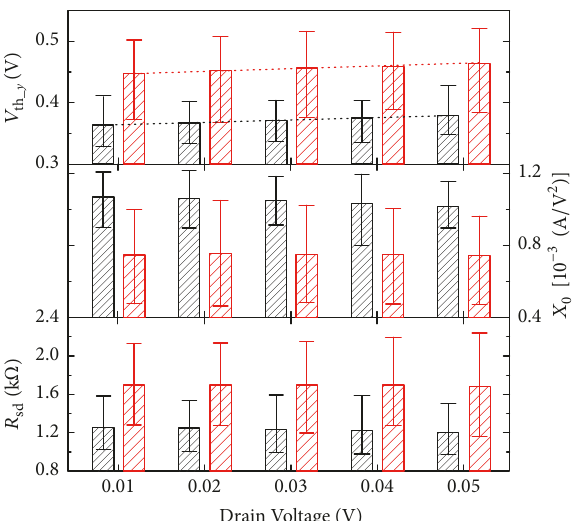
Figure 4: Average and standard deviations of dc parameters for the SOI FinFETs with 𝑇 𝑉 , 𝑋 0 , and 𝑅 . th 𝑦 sd